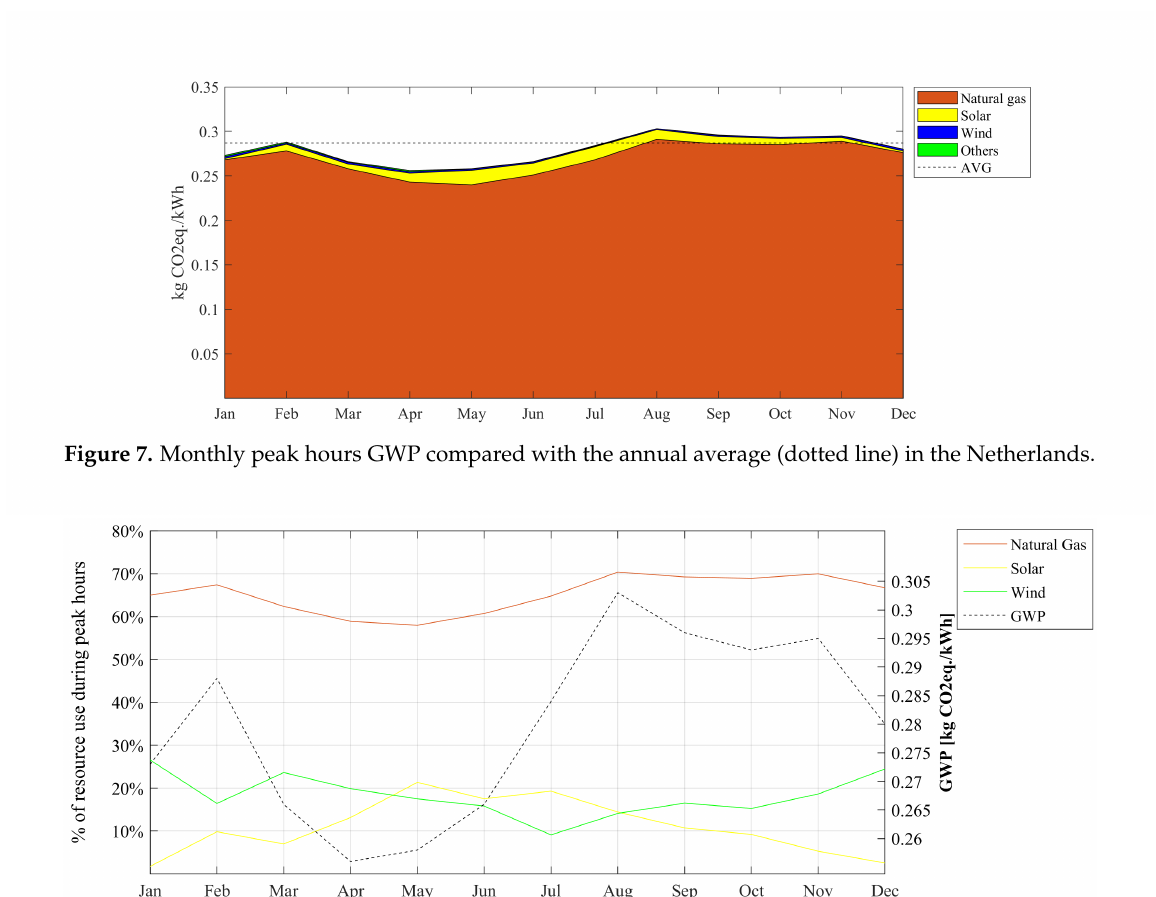
Figure 8. Percentage use of resources throughout the year compared with monthly GWP in the Netherlands, both related to peak hours.